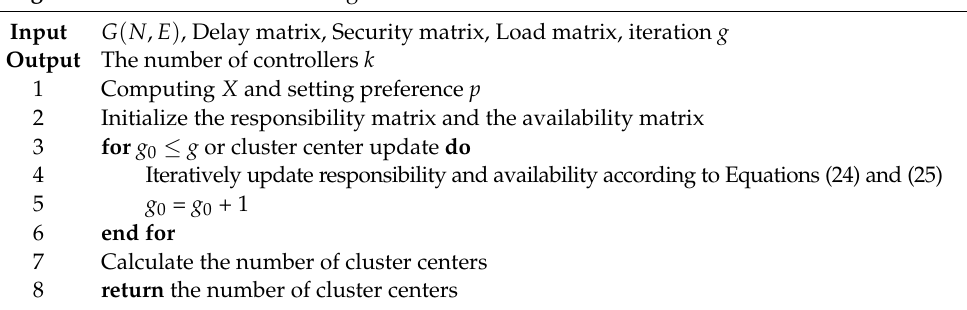
Algorithm 1 Network Partition